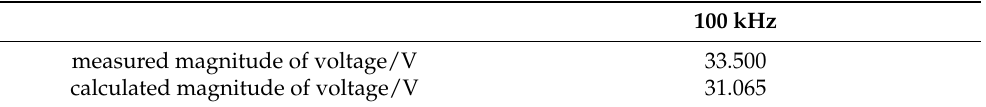
Figure 8. The umbilical cable used in the experiment. Table 1. Comparison of the calculated and measured crosstalk voltages on the impedance.